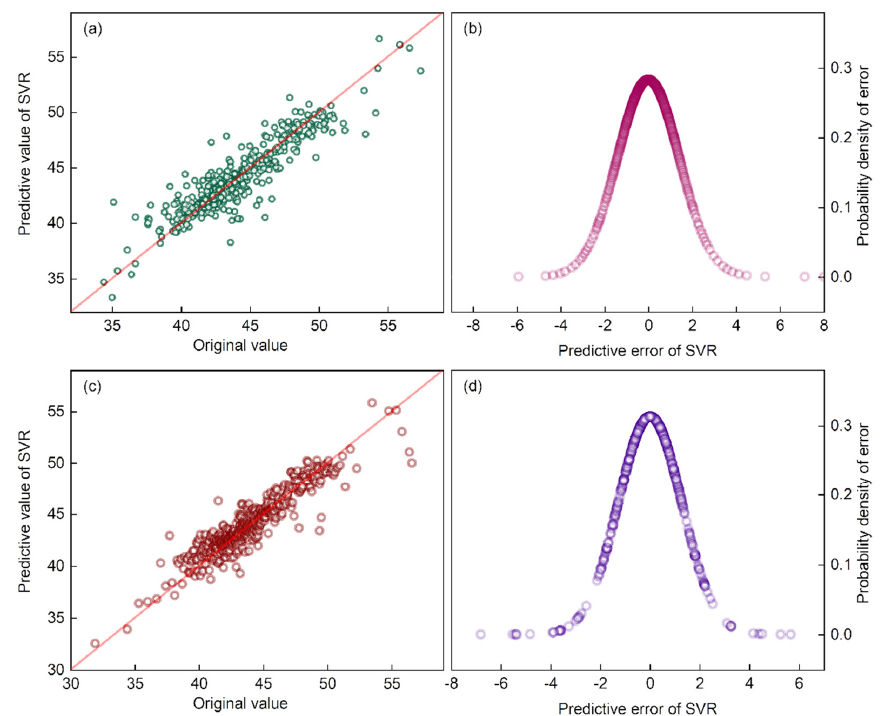
Figure 11. The comparison of the predicted errors of the SVR model (the forecasting parameter is the GUR-3h). Prediction bias ( a ) and probability density of prediction errors ( b ) for the SVR model based on the BDS. Prediction bias ( c ) and probability density of prediction errors ( d ) for the SVR model based on the NDS.